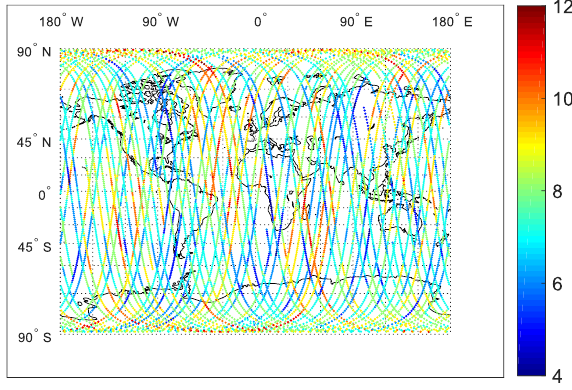
Figure 1. A 24 h in-orbit trace of tracked GPS satellite numbers by LING QIAO GPS receiver.